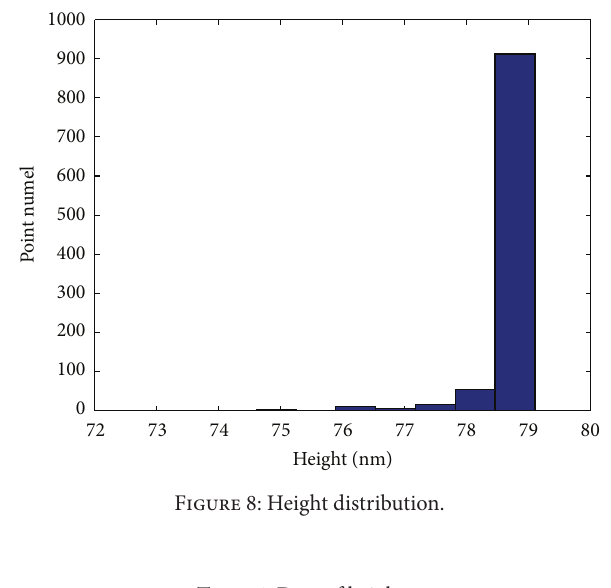
Table 1: Data of heights.